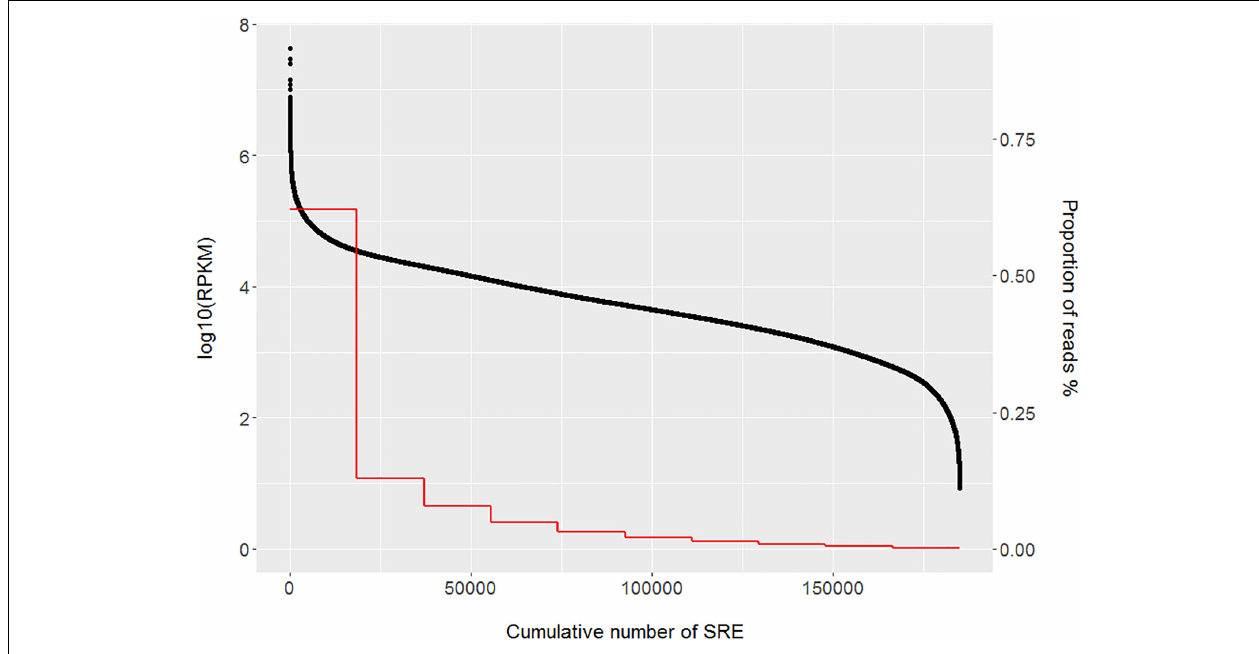
FIGURE 1 | Cumulative abundance of the porcine SREs. The black dots indicate the log10 of the RNA abundance of each SRE. SREs are sorted in a decreasing order by their RNA abundance in the X -axis. The red line represents the total number of SREs for each abundance decile group. The first decile of the most abundant SREs accounted for 65% of the total read abundance. RPKM, reads per kilobase per million mapped reads; SRE, sperm RNA element.